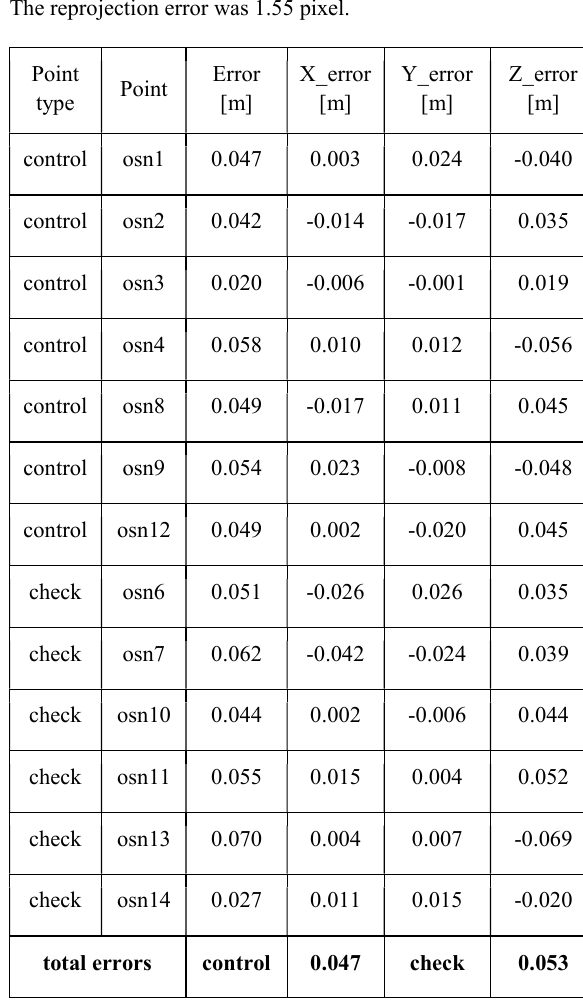
Table 3. List of the checkpoints and control points used for